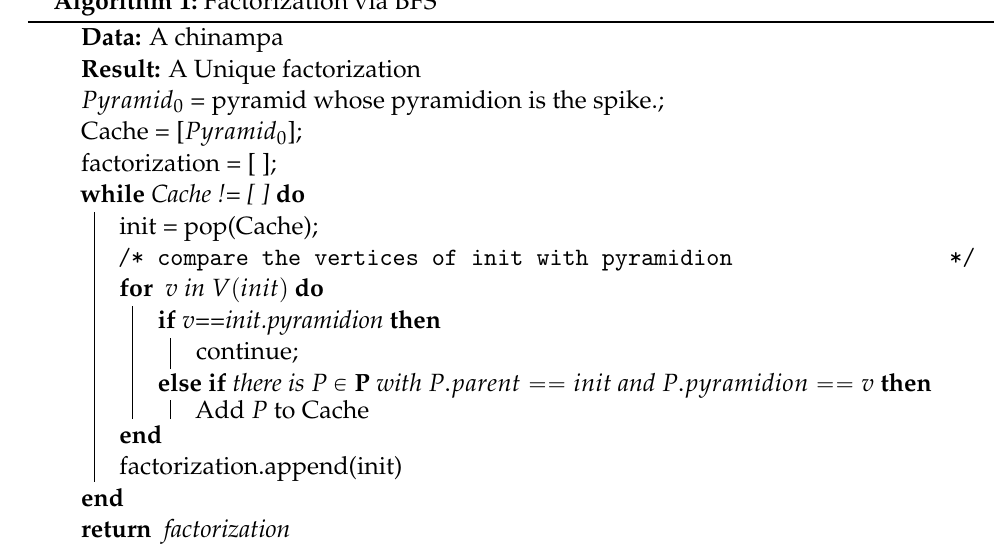
Algorithm 1: Factorization via